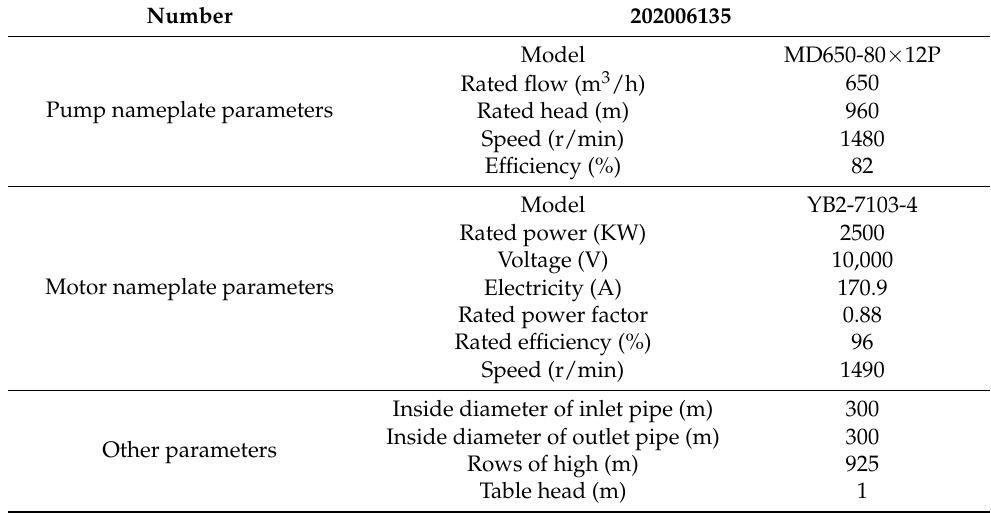
Table 2. The main technical parameters of the MD650-80 × 12P self-balancing multistage pump.